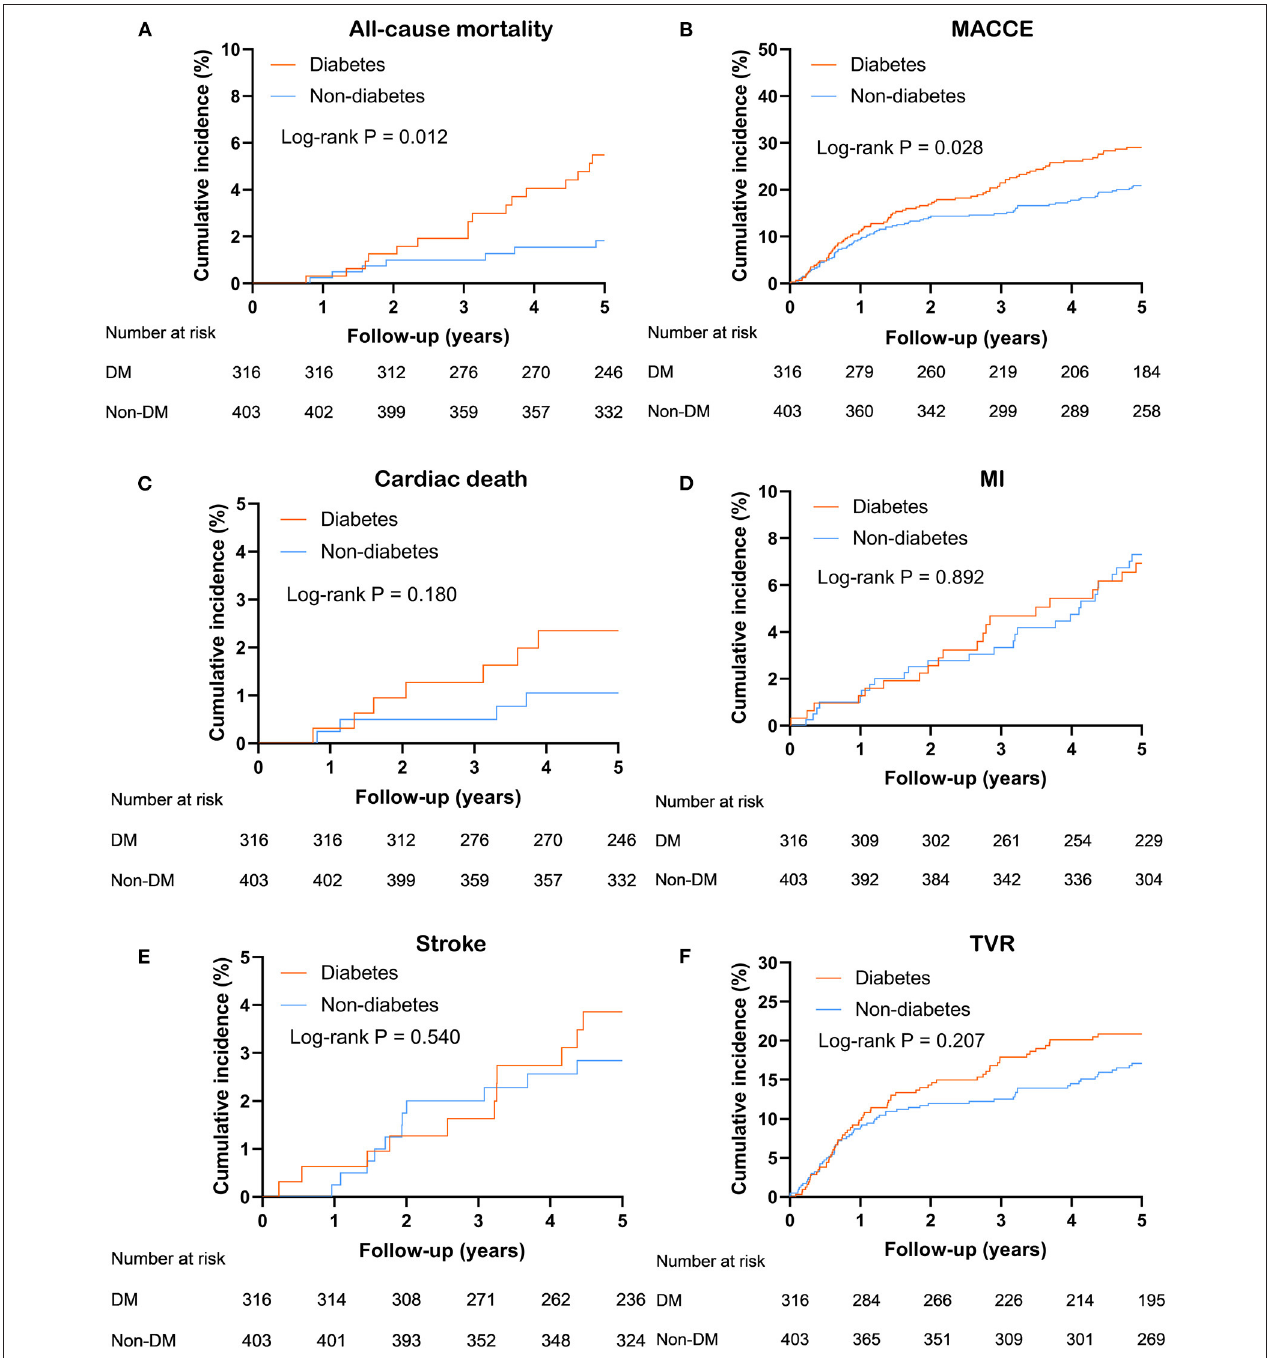
FIGURE 2 | Kaplan Meier survival curves for 5 years (A) all-cause mortality; (B) MACCE; (C) cardiac death; (D) MI; (E) stroke; (F) TVR in entire population. MACCE, major adverse cardiac and cerebrovascular events; MI, myocardial infarction; TVR, target-vessel revascularization.